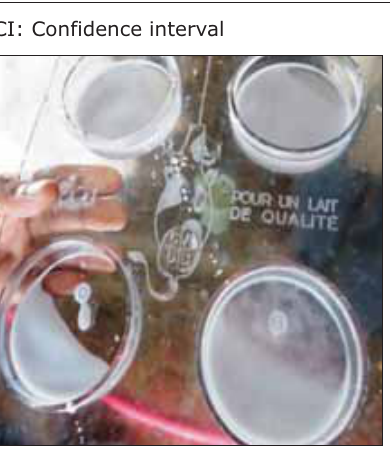
Figure-1(a): Positive california Mastitis Test (visible gel formation within 20 seconds)